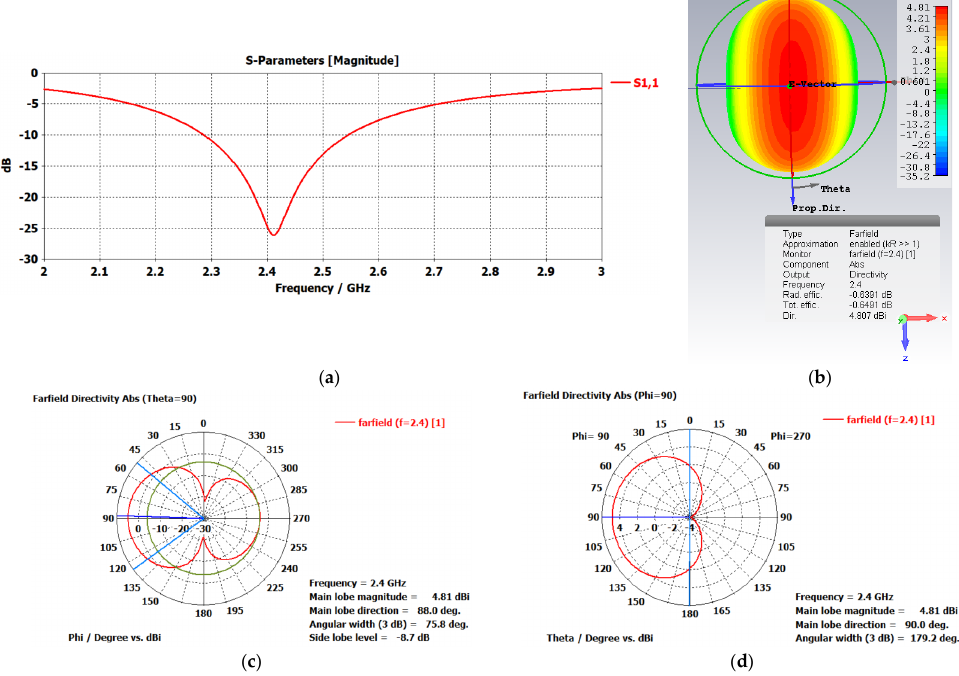
Figure 4. ( a ) Return Loss magnitude; ( b ) Far-Field 3D pattern of dipole antenna; ( c ) 2D Far-Field azimuth view; ( d ) 2D Far-Field elevation view.